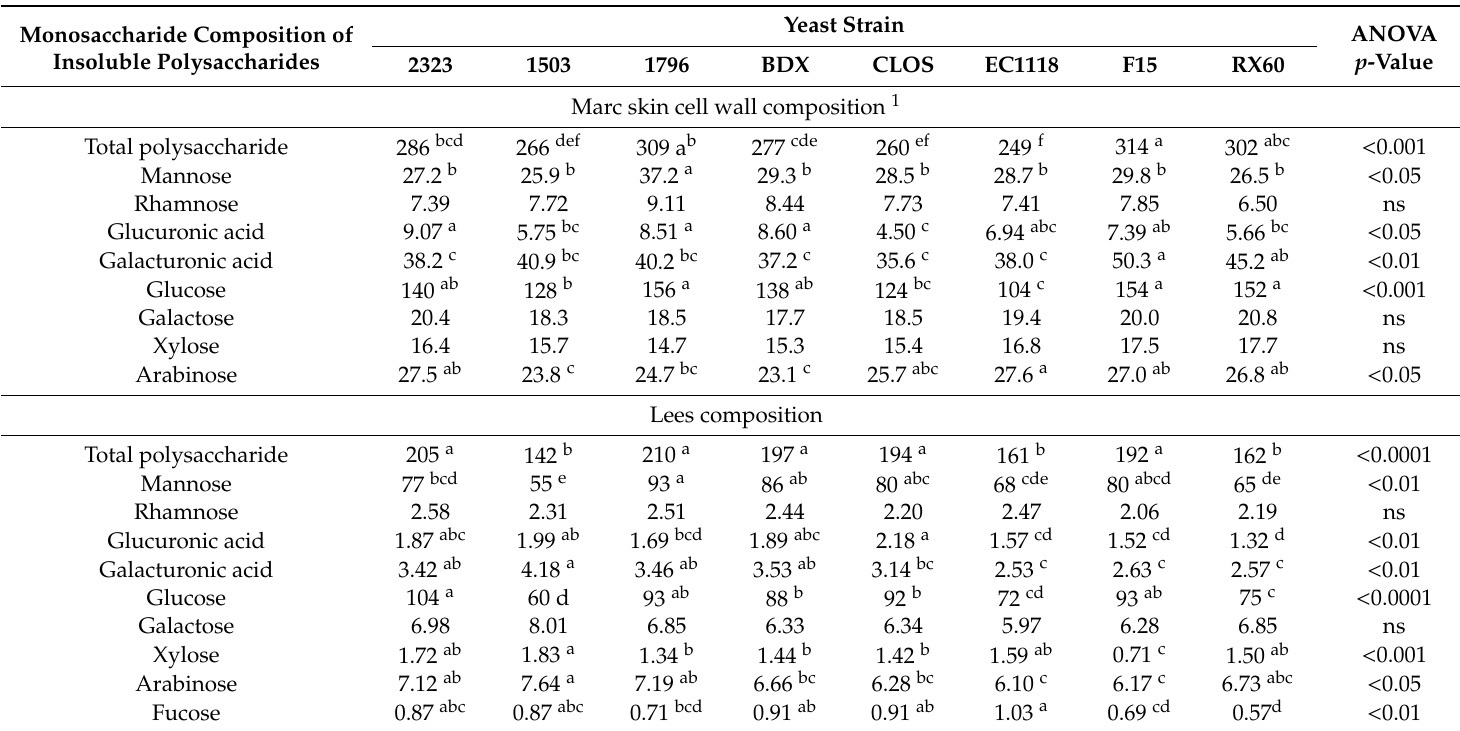
Table 5. E ff ect of yeast strain on the polysaccharide composition (as mg / g dry weight of total and individual monosaccharides) of marcs and lees post-fermentation (data show means compared by one-way ANOVA, where significant di ff erences of p < 0.05 were compared by a post-hoc Student’s t -test, with significant di ff erences within a row shown by di ff erent letters, ns = not